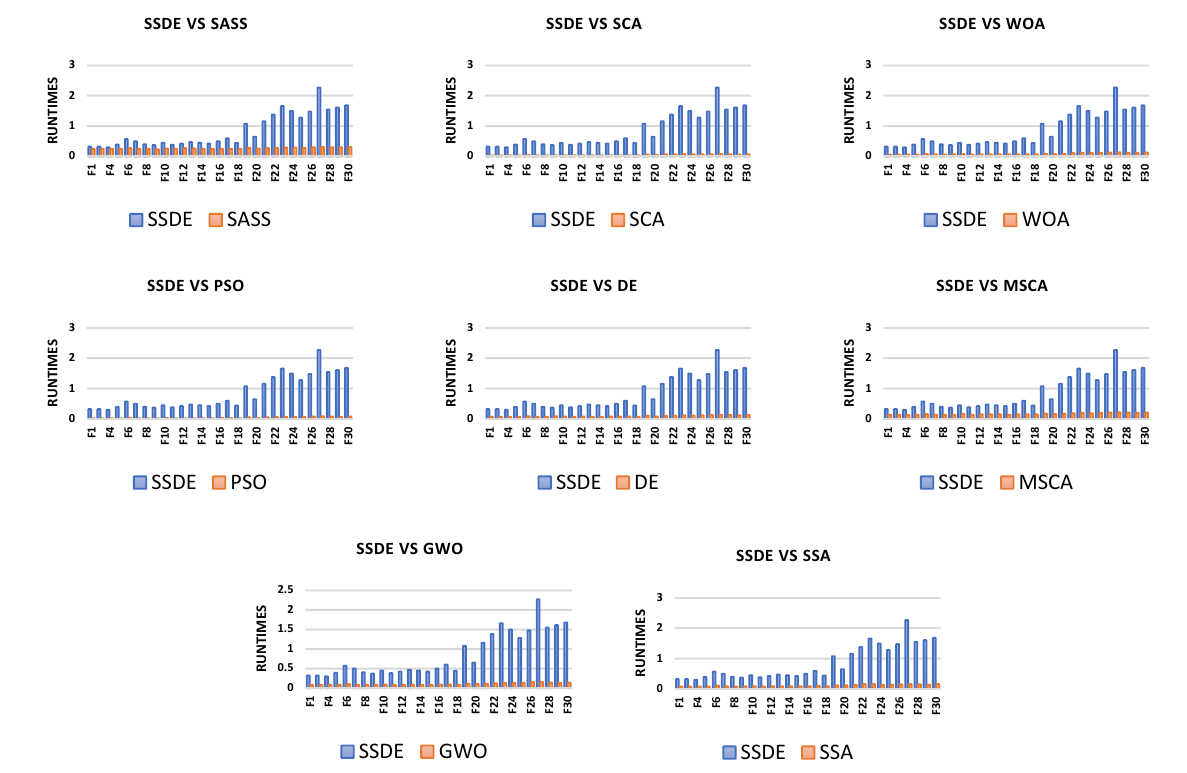
Figure 11. Running time comparison in 10 dimensions.